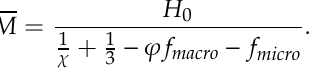
Figure 7. ( a ) Dependence of the threshold field H 0 on the aspect ratio γ for di ff erent MAE samples. ( b ) Dependence of the threshold field H 0 on the shear modulus G 0 for the fixed iron content of 80 mass% and varied aspect ratio γ.